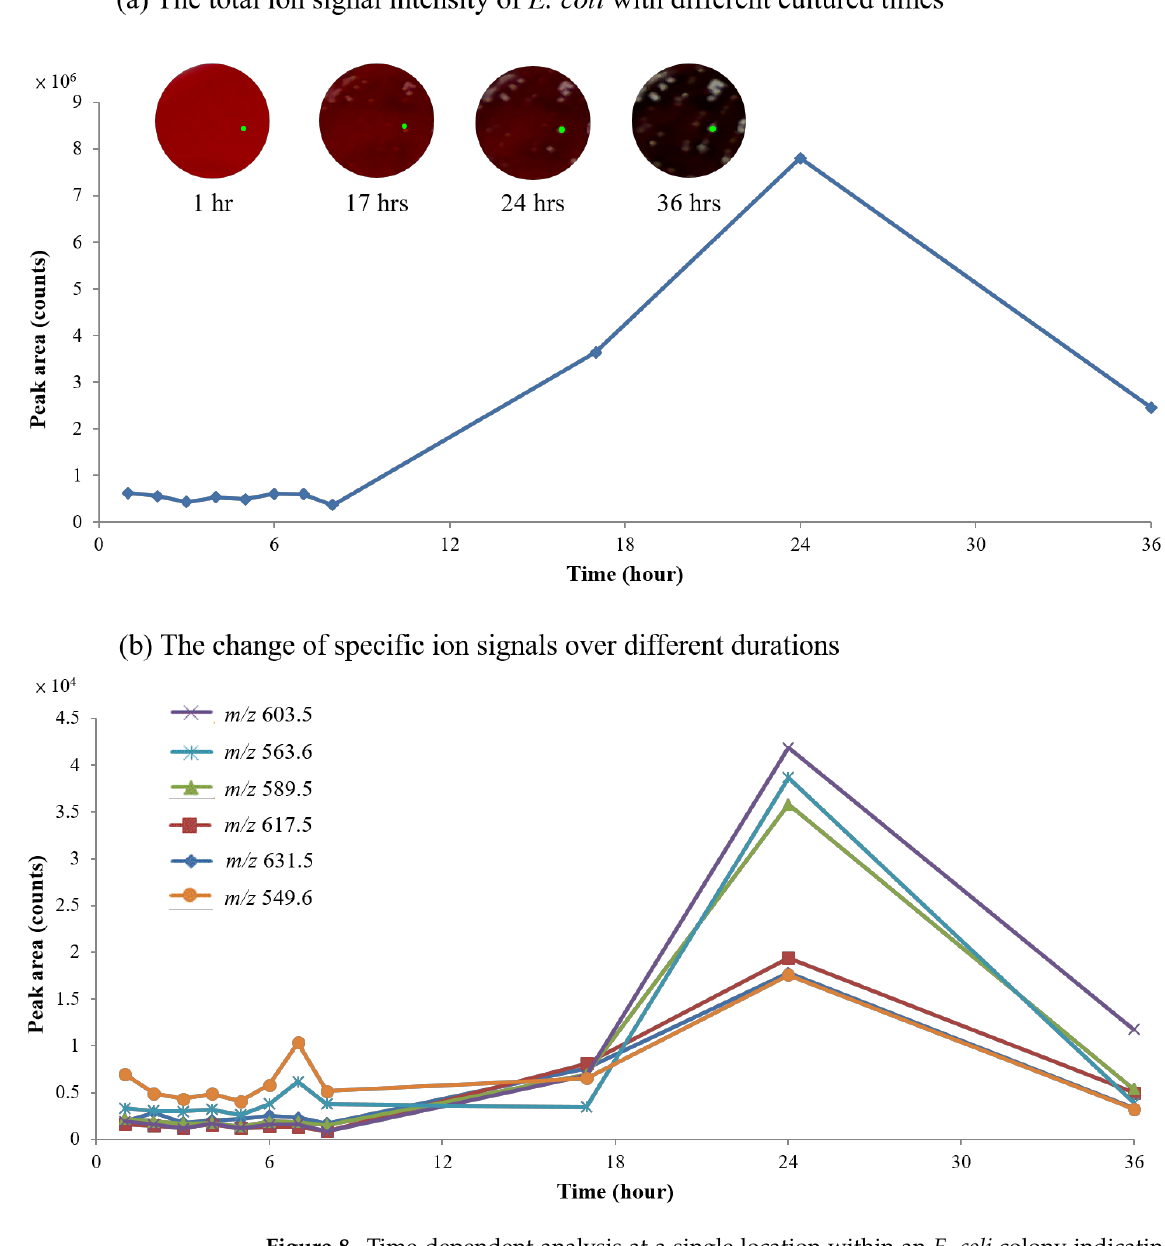
Figure 8. Time-dependent analysis at a single location within an E. coli colony indicating ( a ) the correlation between ion signal intensity and incubation time (inset: photos of E. coli colony growing on a Petri dish with time; green dot: sampling spot), and ( b ) the changes in the ion signal intensity of specific molecules over different durations using TD-ESI/MS. Note: The Y-axis of the line graph was used as an averaged peak area recorded on triplicate experiments to reduce operative variations.